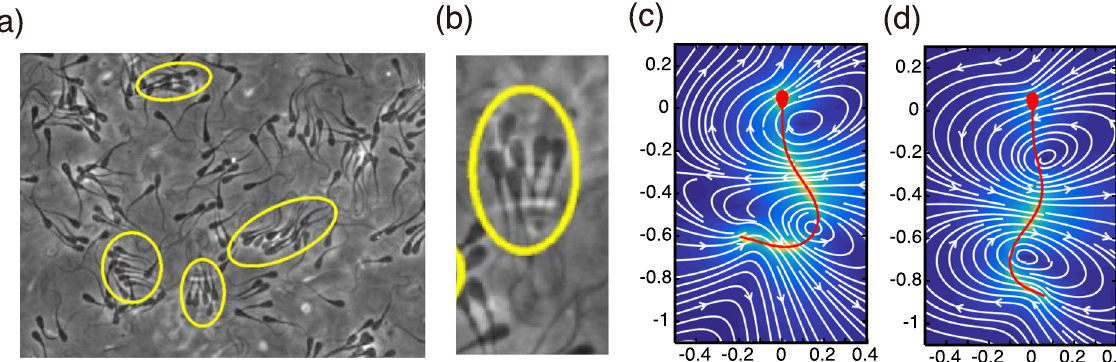
Figure 1. ( a ) Dynamic clustering for bovine sperm in 1% long chain polyacrylamide, reproduced from 4 with permission via the creative commons license, http://creativecommons.org/licenses/by/4.0/. ( b ) A blow up from ( a ), in turn reproduced from Tung et al . 4 , with permission, highlighting that sperm flagella are not necessarily synchronised within a cluster. The predicted fluid flow around a human sperm in a low viscosity, watery Newtonian medium (LVM, ( c )), with dissolved components such as glucose and physiological ions for cell maintenance, together with albumin to prevent sperm-glass adhesion 9 . The analogous predicted fluid flow for a human sperm swimming in a highly viscous–weakly elastic 1% methylcellulose solution (HVM, ( d )), which increased viscosity to about 140 times that of water, which is roughly the average of human female reproductive tract mid-cycle mucus 9,48 . The predicted flow field is an instantaneous snap shot, with axes labels in units of flagellum length, and with the sperm in red, the velocity magnitude given by the intensity of blue shading and the streamlines in white. The data used to generate plots ( c , d ) may be found in the references 35,36